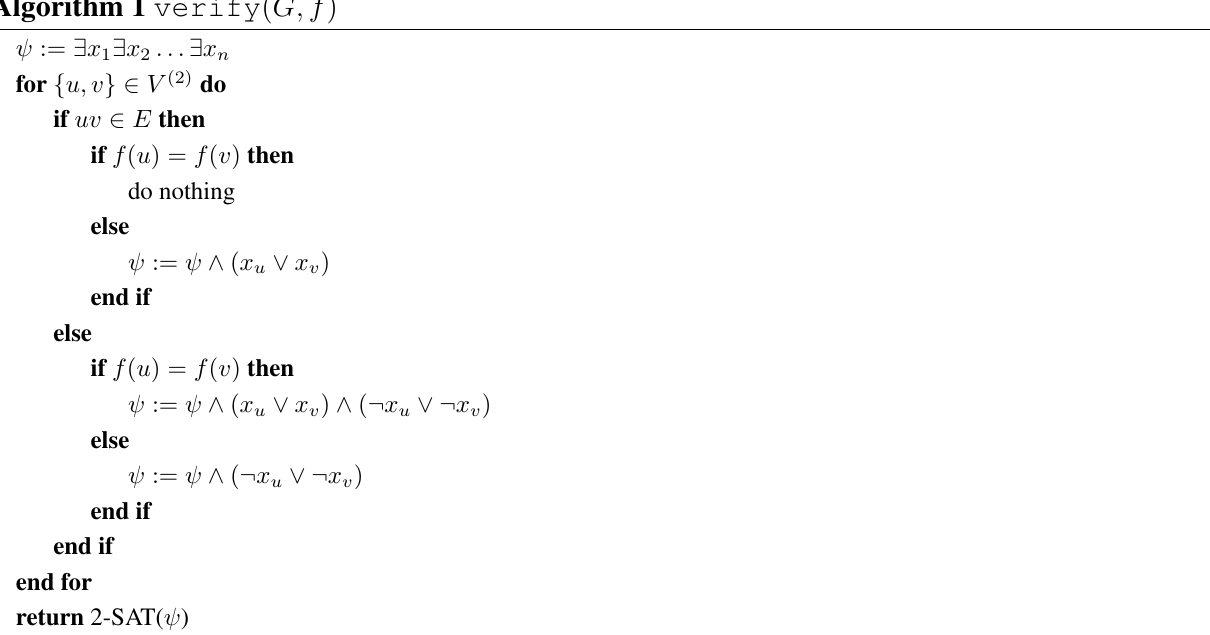
Algorithm 1 verify ( G, f